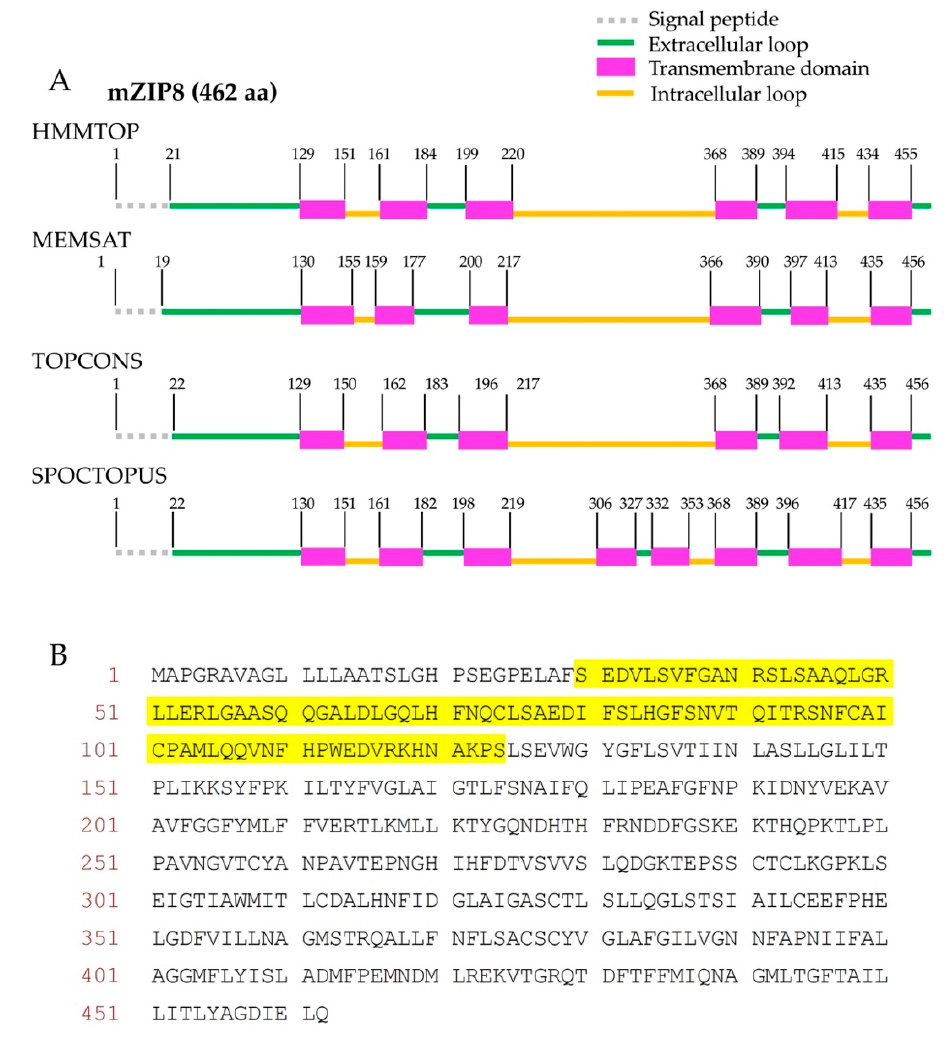
Figure 1. Graphical representation of the topological prediction of mZIP8 by four computational programs. ( A ) The programs HMMTOP, MEMSAT, TOPCONS, and SPOCTOPUS were used to identify putative transmembrane domains and signal peptide in mZIP8 protein. The locations of soluble segments (extracellular or cytosolic loops) and the positions of predicted transmembrane helices are indicated. The number denotes the first amino acid of each segment. (Please note that the length of each segment was not proportional to the actual number of amino acids). ( B ) The amino acid (aa) sequences selected for mZIP8 antigen are highlighted in yellow.